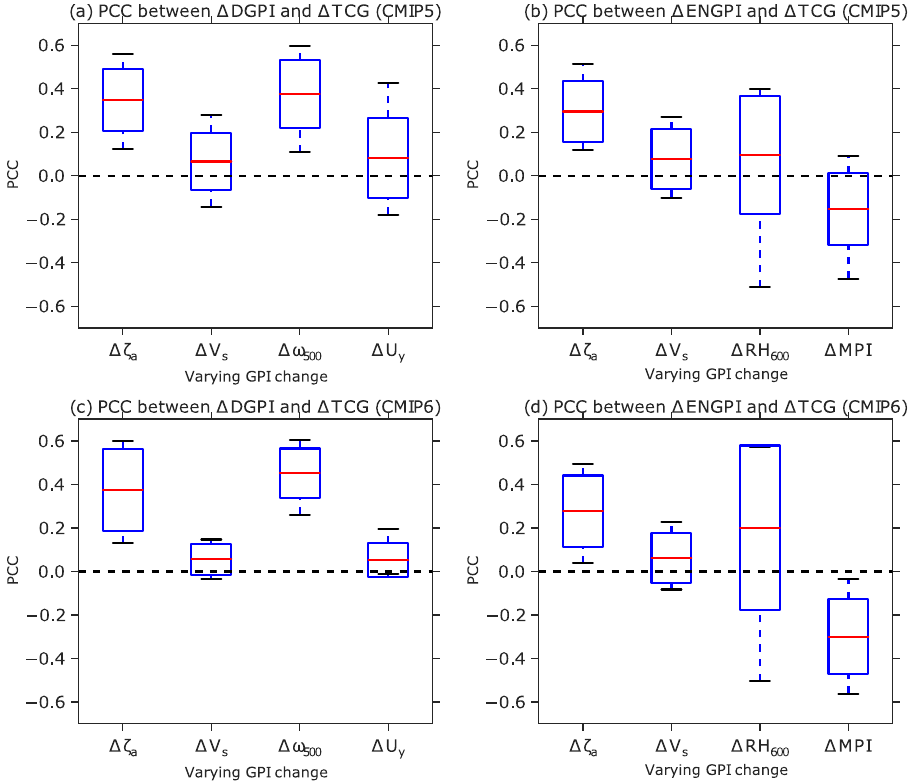
Fig. 5 Spatial PCC between each GPI factor ’ s contribution and the projected TCG frequency. a DGPI and b ENGPI using the 30 CMIP5 model experiments under the RCP4.5 and RCP8.5 scenarios. c and d As in a and b , but for the 10 CMIP6 model experiments under the SSP2-4.5 and SSP5- 8.5 scenarios. The box plots show the PCC between the changes in TCG frequency and the changes in GPI by varying a single factor. The abscissa in a , c denotes DGPI changes by varying absolute vorticity ( 4 ζ a ), vertical wind shear ( 4 V s ), vertical motion ( 4 ω 500 ), and mid-level vorticity ( 4 U y ), respectively. The abscissa in b , d denotes ENGPI changes by varying absolute vorticity ( 4 ζ a ), vertical wind shear ( 4 V s ), RH ( 4 RH 600 ), and MPI ( 4 MPI), respectively. The boxes represent the range of one standard deviation of the correlations; the horizontal red lines show the mean value, and the dashed bars show the 5% and 95%